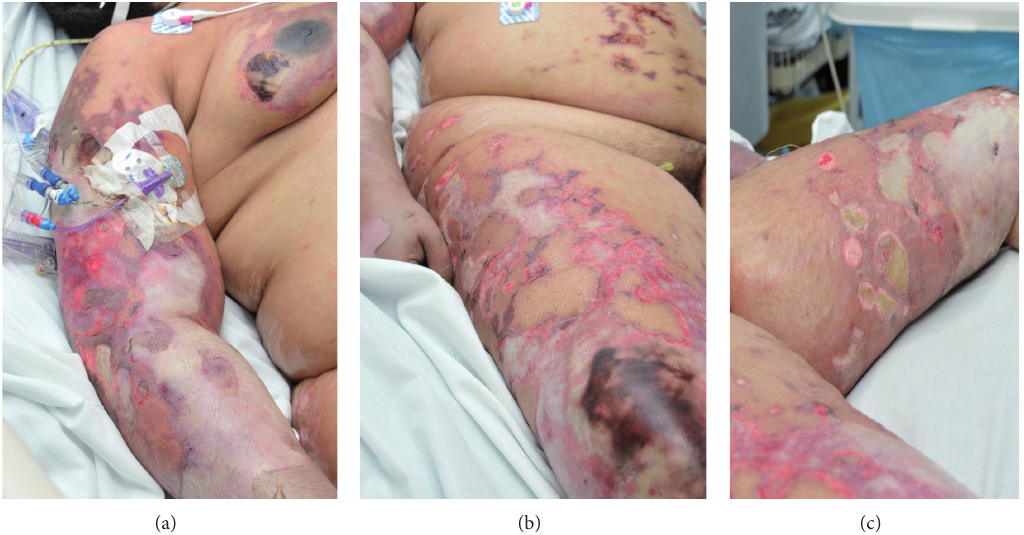
Figure 2: Large patches of denuded skin over the chest, breasts, arms, legs, upper back, and buttocks with nondenuded areas appearing mottled and